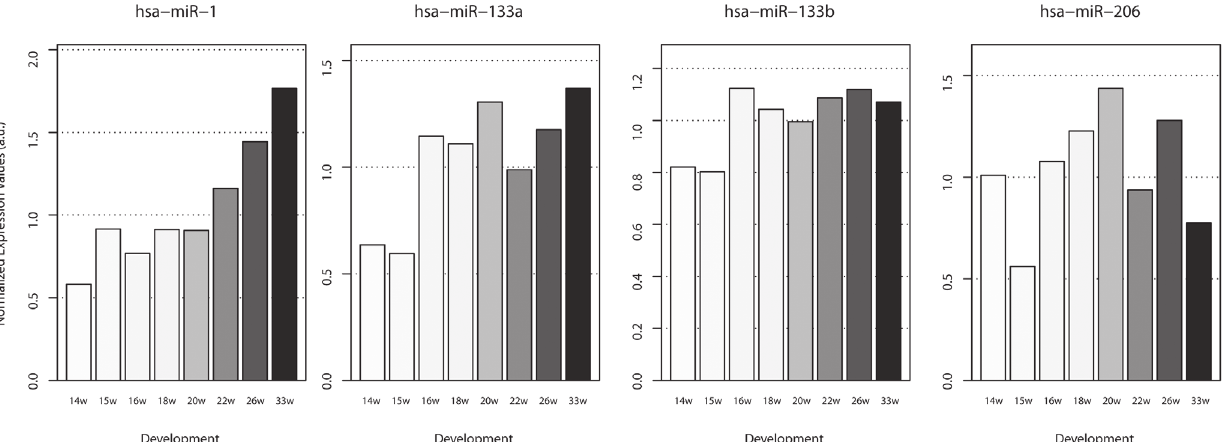
Figure 1. Expression of myomiRs during normal human skeletal muscle development. qPCR for myomiRs were performed on control muscle biopsies at 16 – 33 weeks of